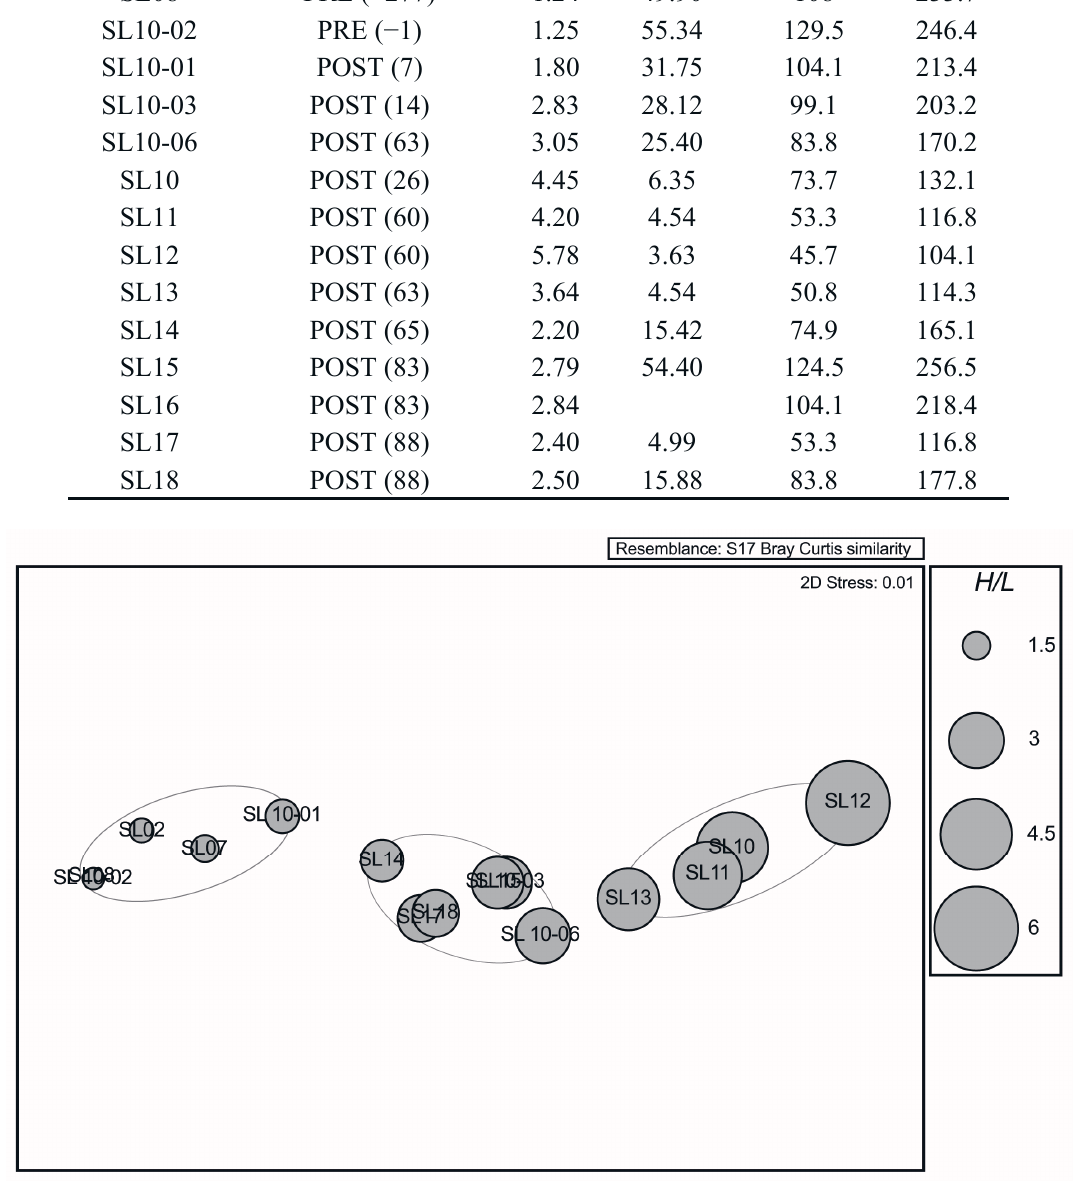
Figure 3. A Multidimensional scaling (MDS) ordination plot based on Bray Curtis similarity of alligator heterophil to lymphocyte ratios post oil inundation with three 70% resemblance cluster groups highlighted; Pre-disturbance with 1 individual pre- and two post-disturbance groups. Stress (the amount of distortion required to plot a 3D MDS on a 2D plane) =